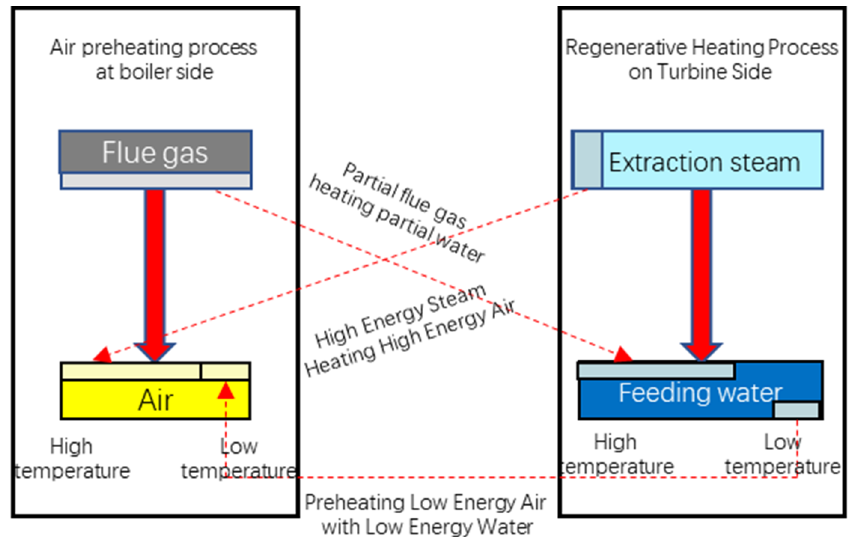
Figure 5. Schematic diagram of a new boiler-turbine coupling.